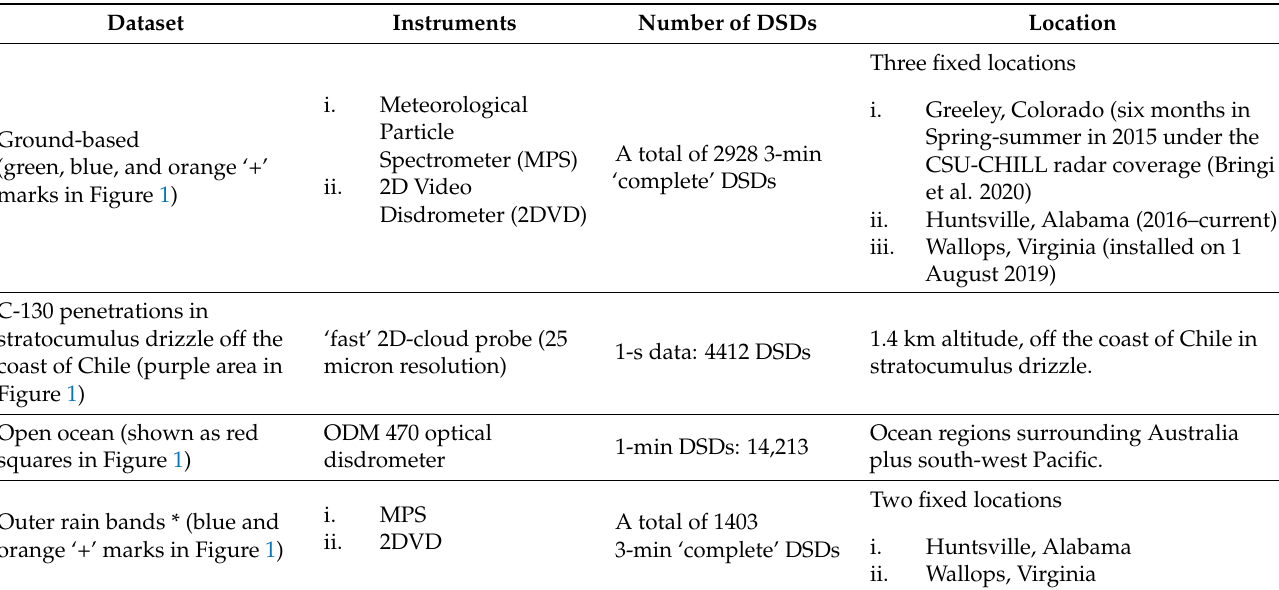
Table 1. Brief summary of the ground-based/OceanRain and C-130